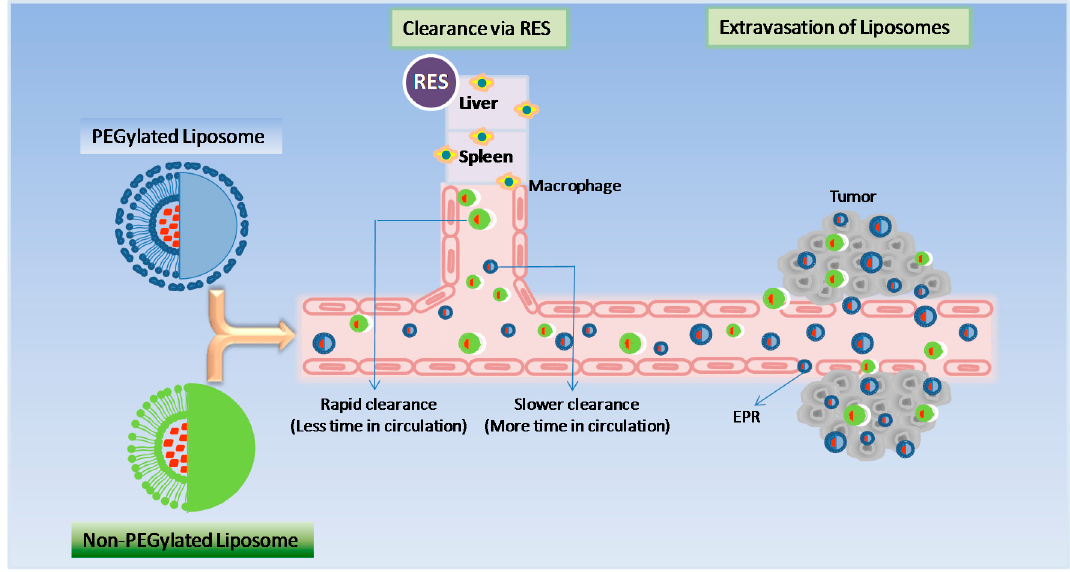
Figure 3. Pharmacokinetics of PEGylated liposomes and Non-PEGylated liposomes.